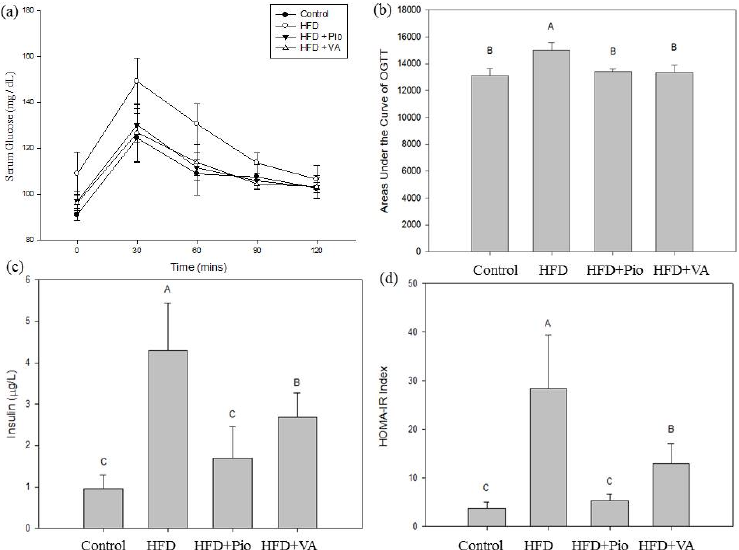
Figure 1. ( a ) Oral glucose tolerance test (OGTT); ( b ) area under the curve for glucose (AUC glucose